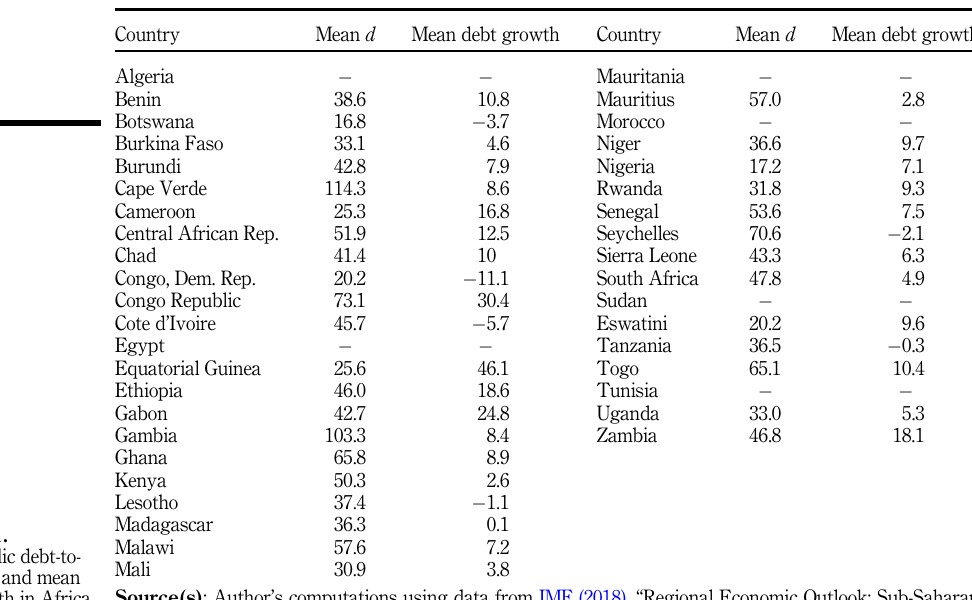
Table A1. Mean public debt-to- GDP ratio and mean debt growth in